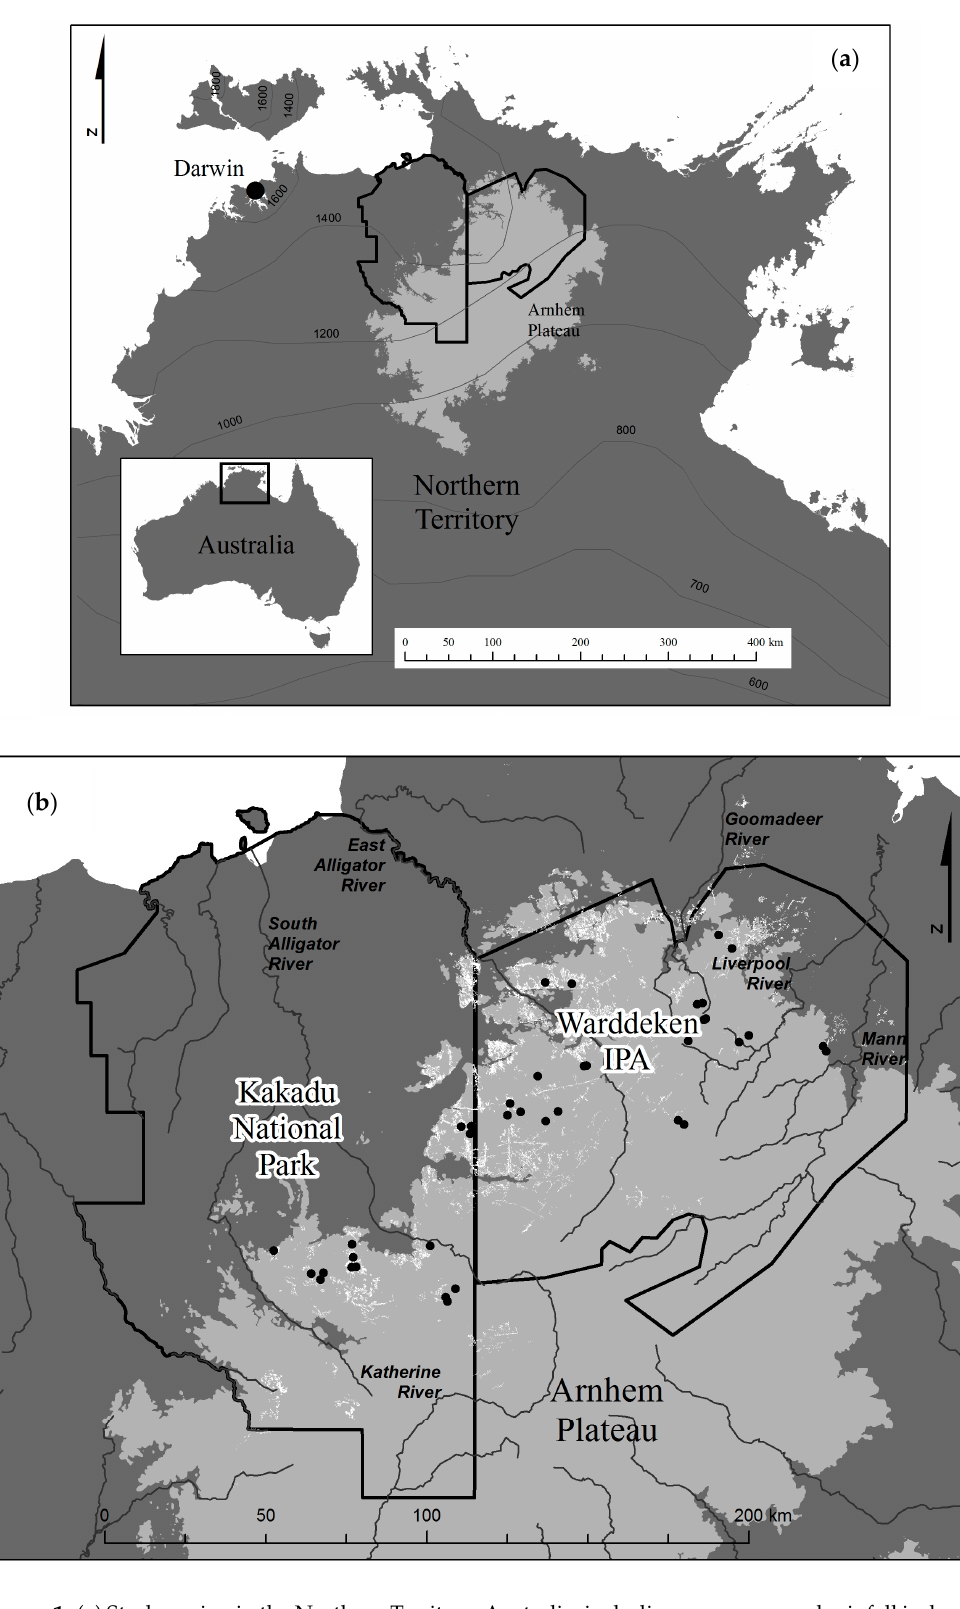
Figure 1. ( a ) Study region in the Northern Territory, Australia, including mean seasonal rainfall isohyets (mm); and ( b ) the mapped distribution of Allosyncarpia forest outlined in white, and the location of 40 sample sites used for the canopy cover change assessment.